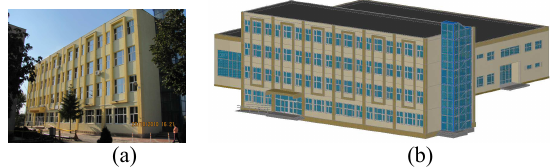
Figure 12. (a) Digital image of the building facade (b) The 3D model of the building after applying texture (South-East view)